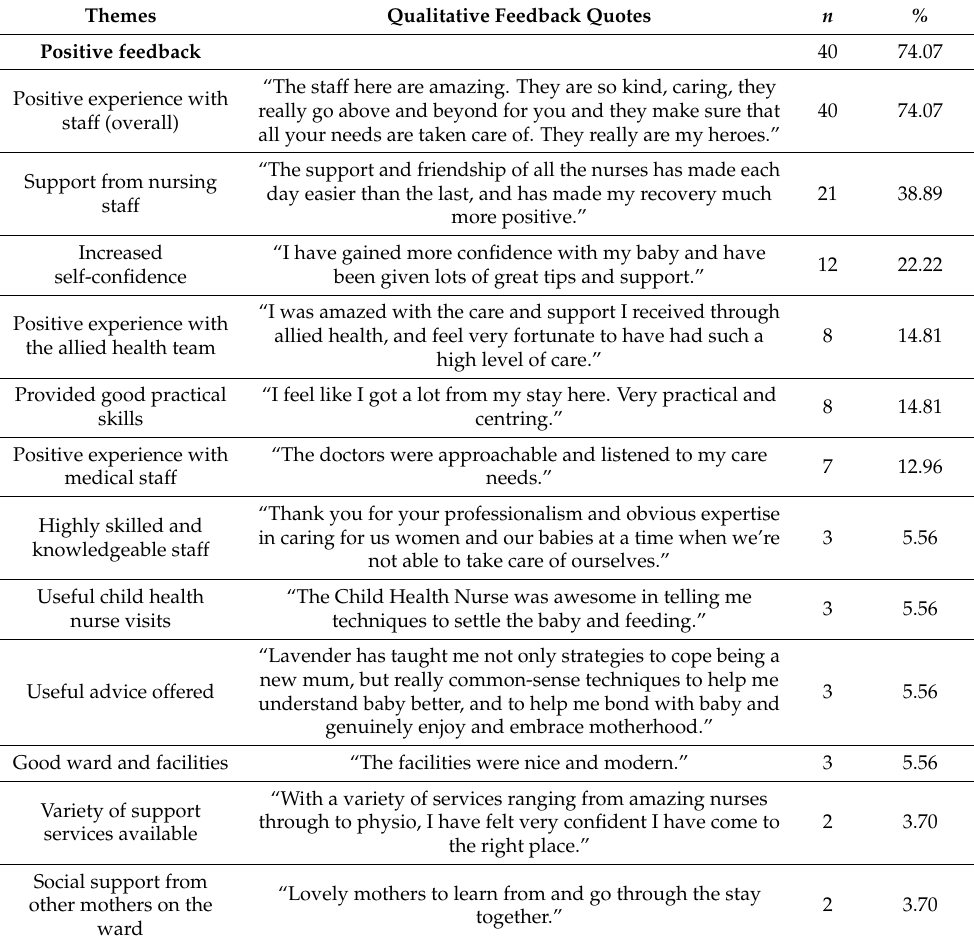
Table 6. Thematic Analysis of Qualitative Consumer Feedback ( n =